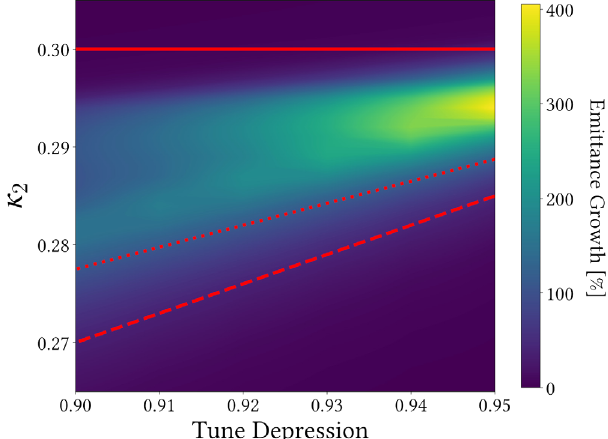
FIG. 11. Density dependence of the linear resonance band of the full Gaussian distribution without the tail truncation. The rms emittance growth after 200 AG focusing periods are evaluated with the W ARP code at different tune depressions and linear perturbation frequencies. Other numerical conditions (the oper- ating tunes, perturbation strength, etc.) are the same as those assumed in Fig. 9. The dotted line is based on the coherent resonance condition in Eq. (14) with C 2 ¼ 0 . 75 . The solid and dashed lines indicate, respectively, the single-particle resonance condition in Eq. (2) and the incoherent resonance condition in Eq. (4) with Δ ν replaced by Δ ¯ ν .